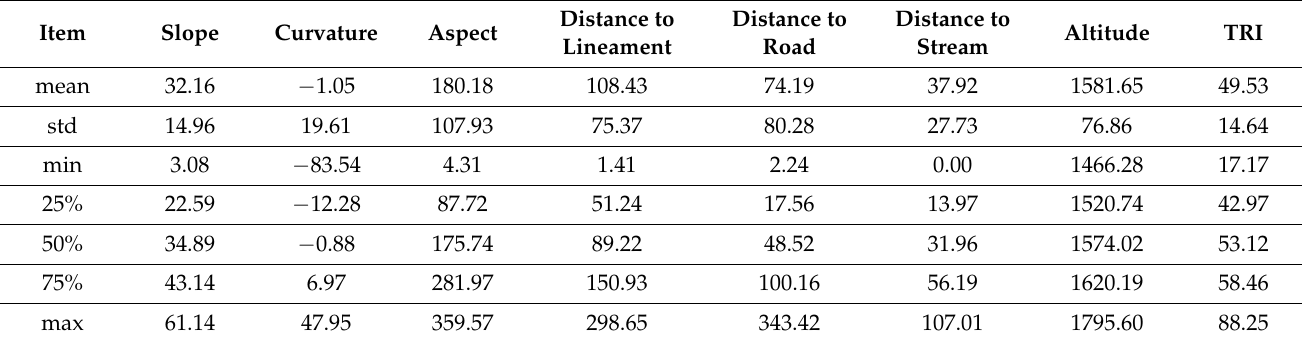
Table 2. Summary statistics of the data used in the current study. The samples include a total of 70 events including 35 landslides (positive) and 35 random non-landslides